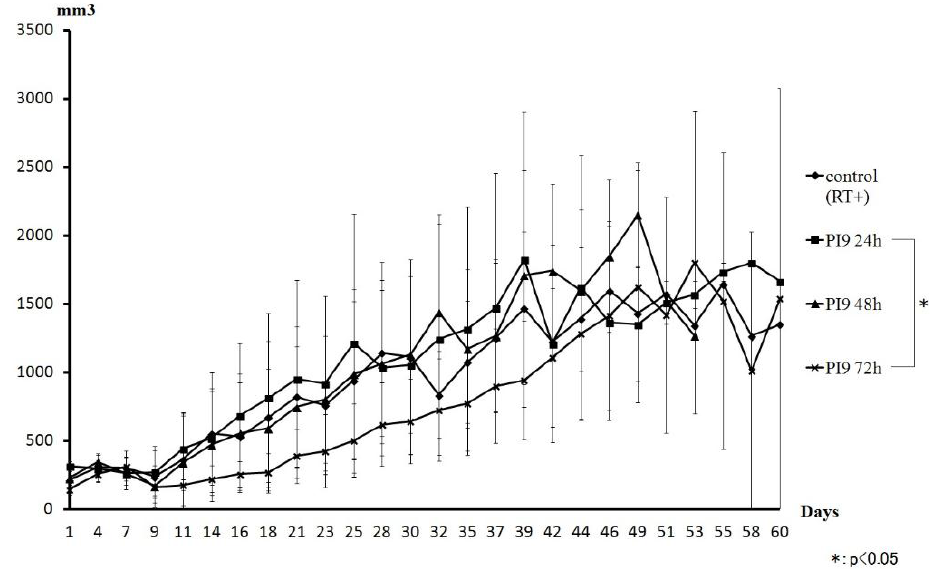
Figure 6. Comparison of the tumor volume curve for the PI9 and control groups. An inhibitory effect was seen in the group irradiated after 72 h. However, that group showed almost the same change as other groups on and after day 42. The PI9 (24 h) and PI9 (48 h) groups showed almost the same transition as the control group. During the observation period, the PI5 groups showed disappearance of mouse tumors in all three time groups.